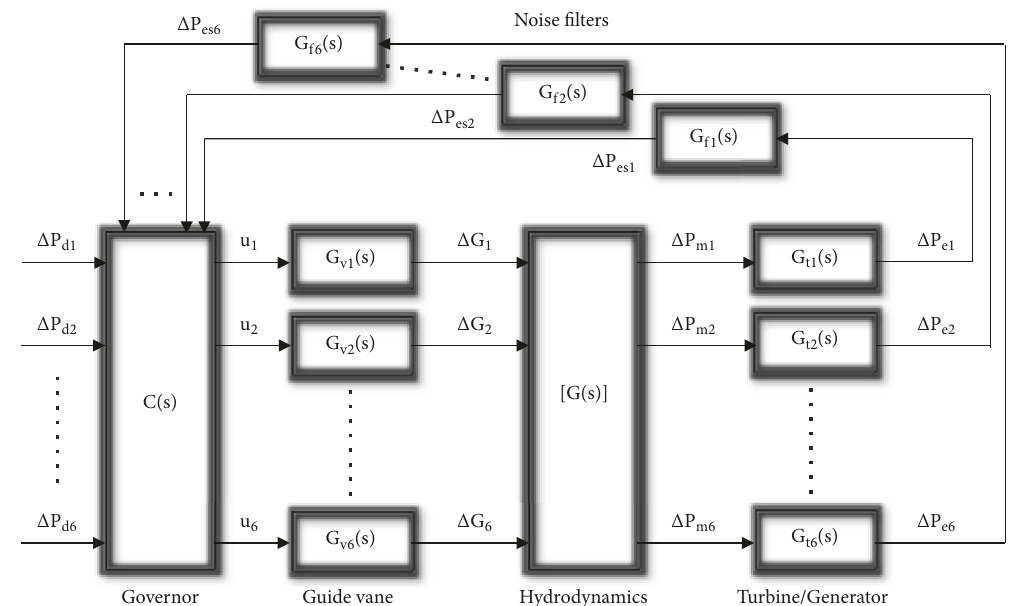
Figure 2: Subsystems of the power plant